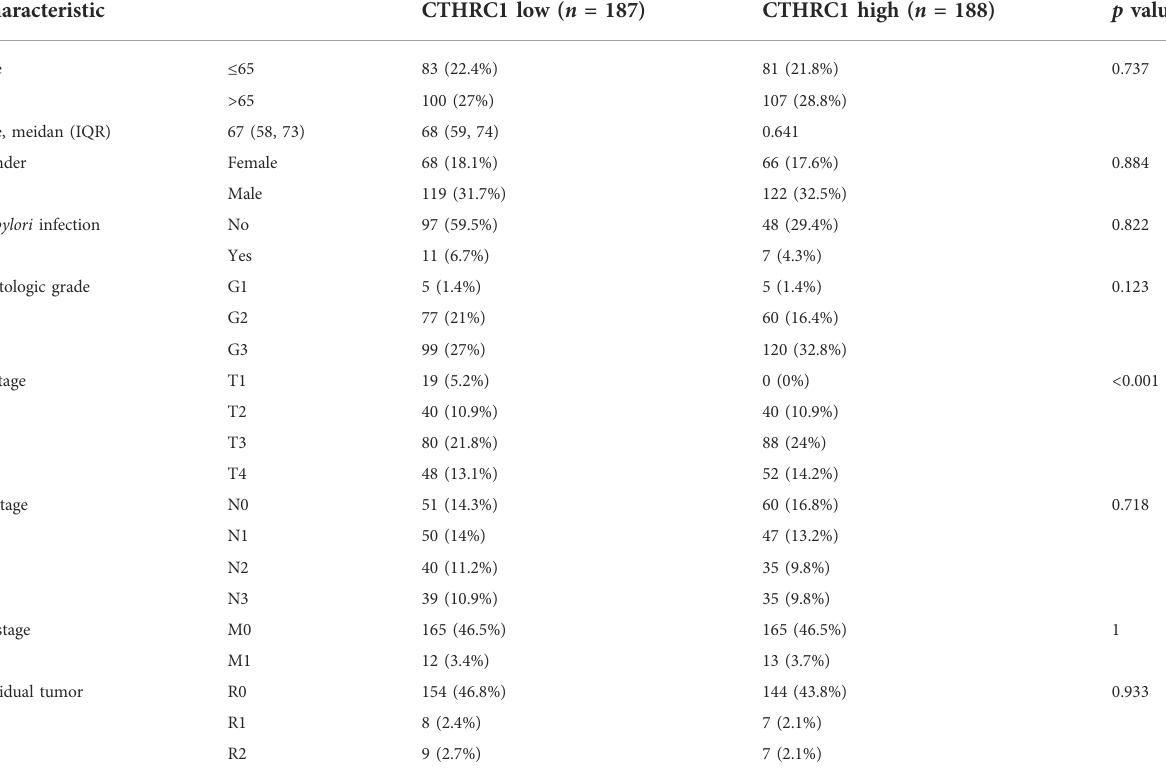
TABLE 1 CTHRC1 expression and clinical characteristics in gastric